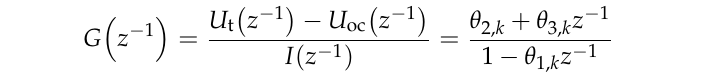
Table 1. Curve fitting coefficient.